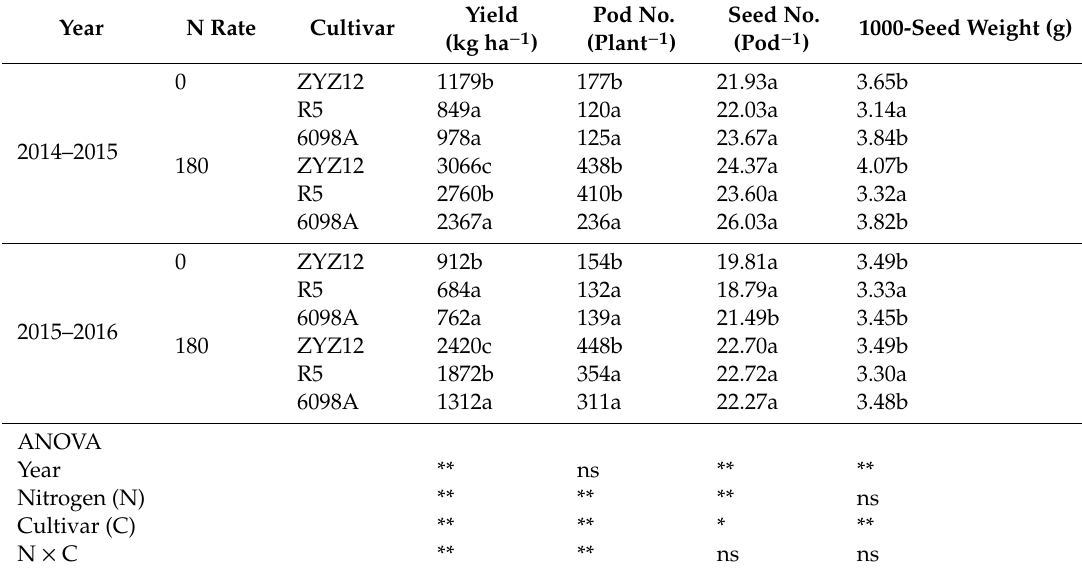
Table 4. Yield and yield components of the three oilseed rape cultivars grown at two N rates during the level of p < 0.05 within each N rate in the same season. *, p < 0.05; **, p < 0.01.